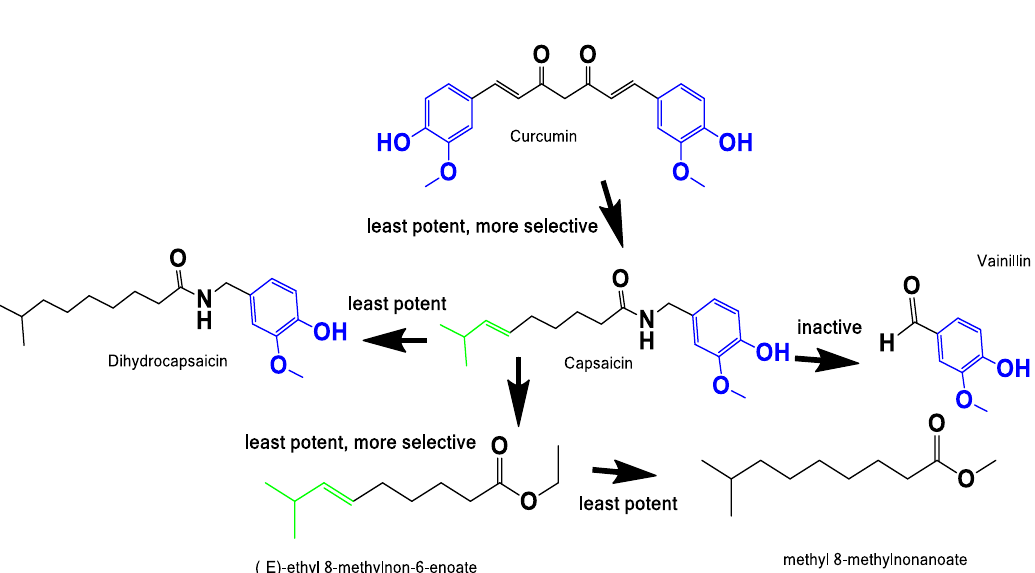
Figure 7. Structure activity relationship. Exploration of the possible pharmacophore responsible for the cytotoxic/anti-proliferative activities against LNCaP. Color codes indicate the vanillin motif (blue), and vinyl motif (green). The “potency” refers to the activity of the compound in LNCaP and the selectivity towards malignant vs benign cells.